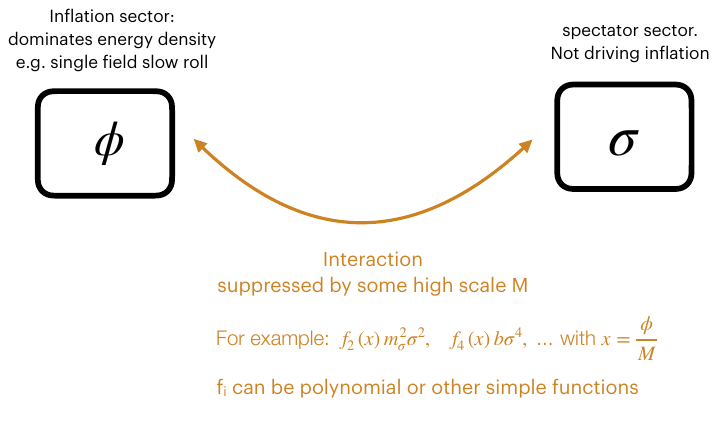
Figure 1 . Inflaton with coupling to an spectator